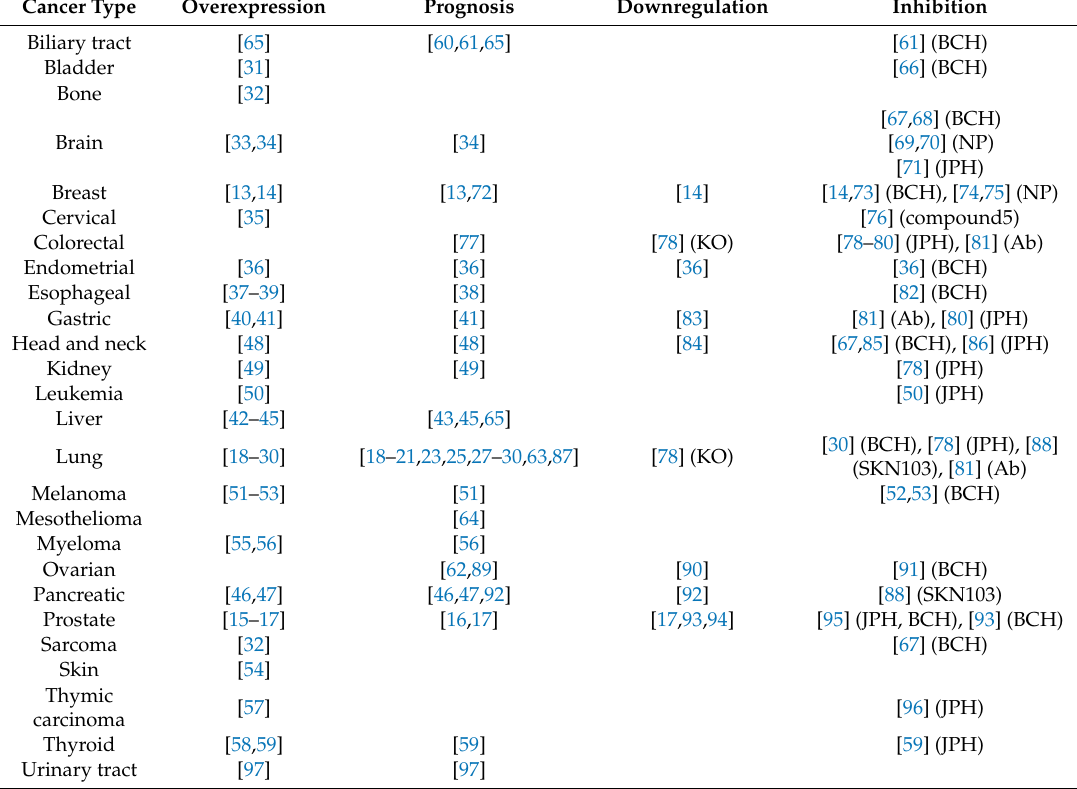
Table 1. Role of l -type amino acid transporter (LAT1) in di ff erent tumor